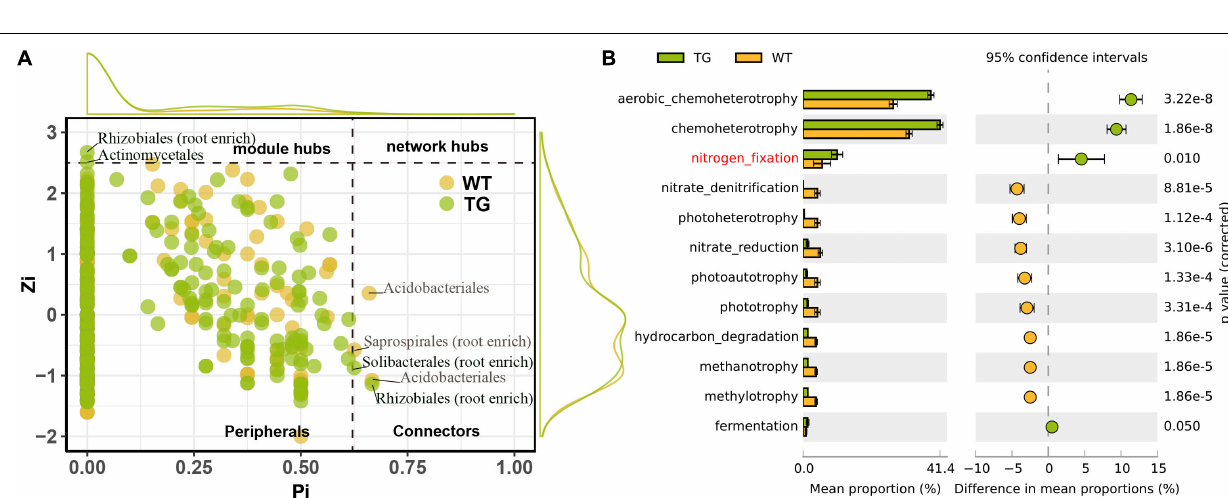
Frontiers in Microbiology |